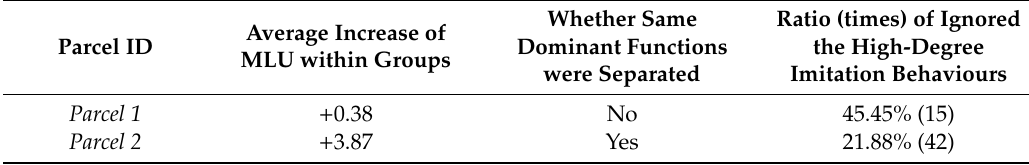
Table 4. Analysis of parcel grouping results based on infiltration behaviours (k-means ++ ).